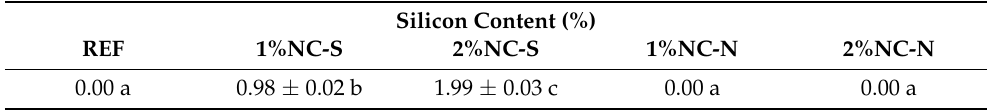
Table 5. Silicon content in the cured UF adhesive.